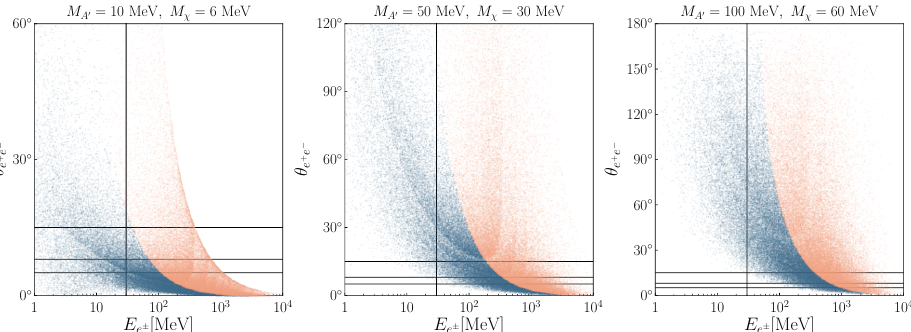
Figure 7 . The (cid:12)nal state e + e (cid:0) opening angle versus energy distribution for three dark matter and dark photon mass combinations. We (cid:12)x the dark matter to dark photon mass ratio to be 0 : 6. In each event, the energy of the more (less) energetic charged lepton is represented by an orange (blue) point. The distributions are obtained by convolving with the energy spectrum of the incoming (cid:31) beam. The patterns in the bulk of each region are numerical artifacts. The vertical line corresponds to E = 30 MeV. The horizontal lines correspond to (cid:18) = 5 (cid:14) ; 8 (cid:14) ; 15 (cid:14) e (cid:6) e + e (cid:0)